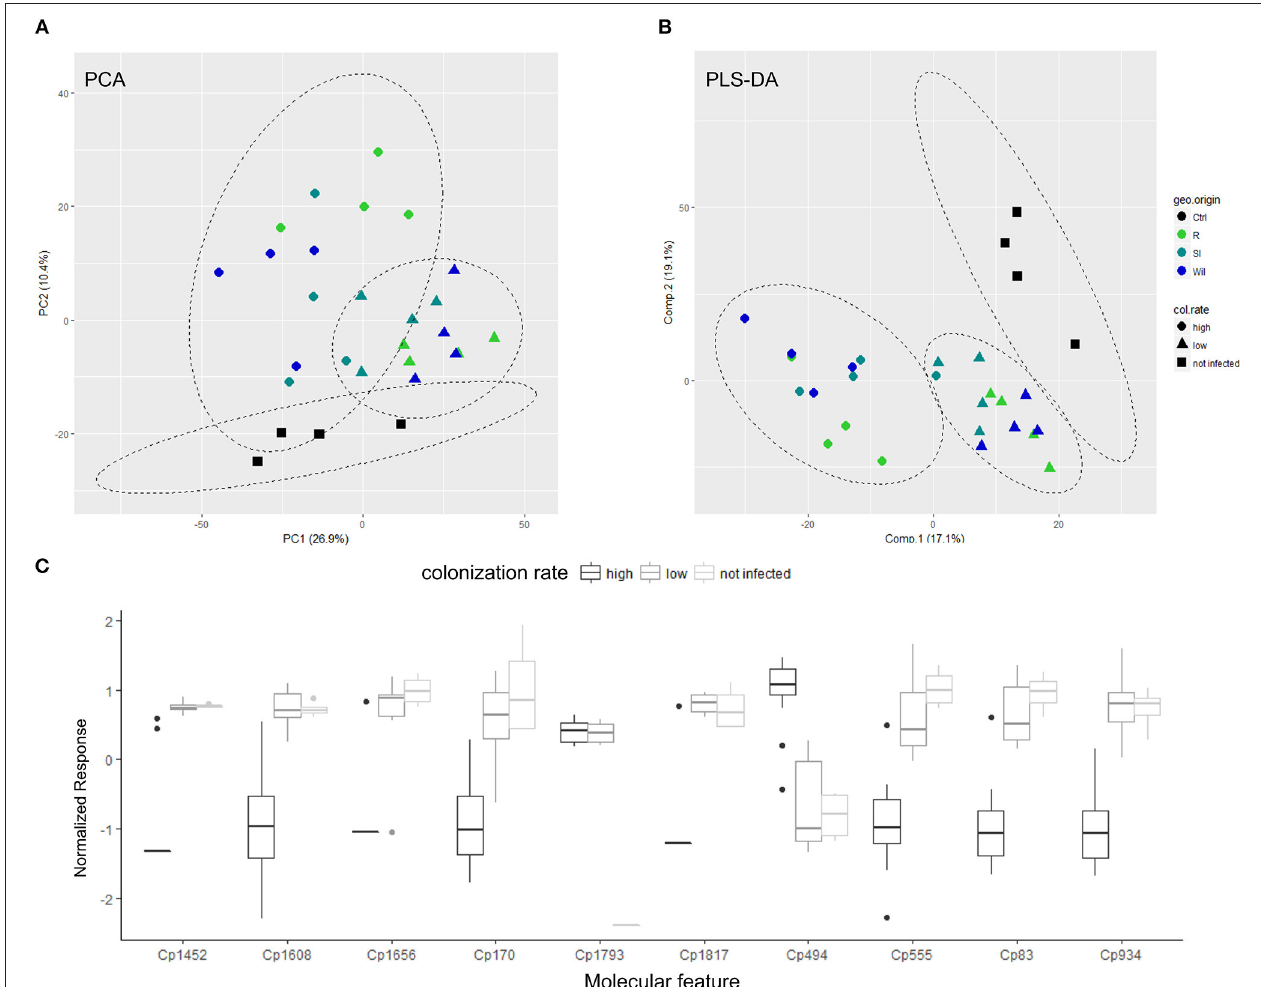
FIGURE 4 | Specific metabolites exhibit correlation to root colonization potential of interacting- Pisolithus isolate. (A) PCA score plot showing the multivariate-variation among Pisolithus -interacting root tips samples in terms of metabolite profiles derived from LC-MS (ESI + mode). (B) PLS-DA score plot showing the first two components of the supervised classification PLS model that separates metabolite profiles of Pisolithus -interacting root tips samples in terms of colonization rate. The color of the symbols represents the geographical origin (geo. origin) of the Pisolithus strains, while the shape of the symbols represents the colonization rates (col. rate). Ctrl, un-infected control roots; R, Royal National Park; SI, Sussex Inlet; Wil, Wilberforce. (C) The boxplot depicting the response levels of the top-10 important features with highest VIP scores that are derived from the first component of the PLS model. Responses = intensity of compound peak/intensity of internal standard / fresh weight (g). Normalization of metabolite responses is done with generalized logarithm followed by